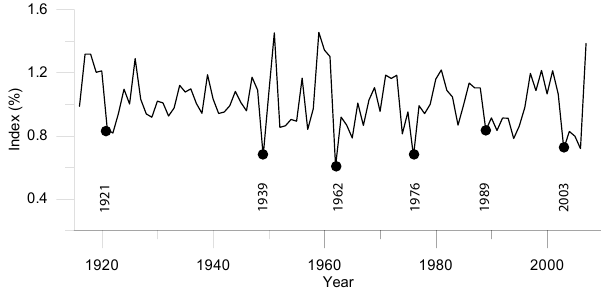
Fig. 4. Tree-ring chronology of Pinus sylvestris L. for the Manival torrent dating back to 1918. Individual series are detrended with (i) a negative exponential curve or a linear regression and (ii) by a cubic smoothing spline function.